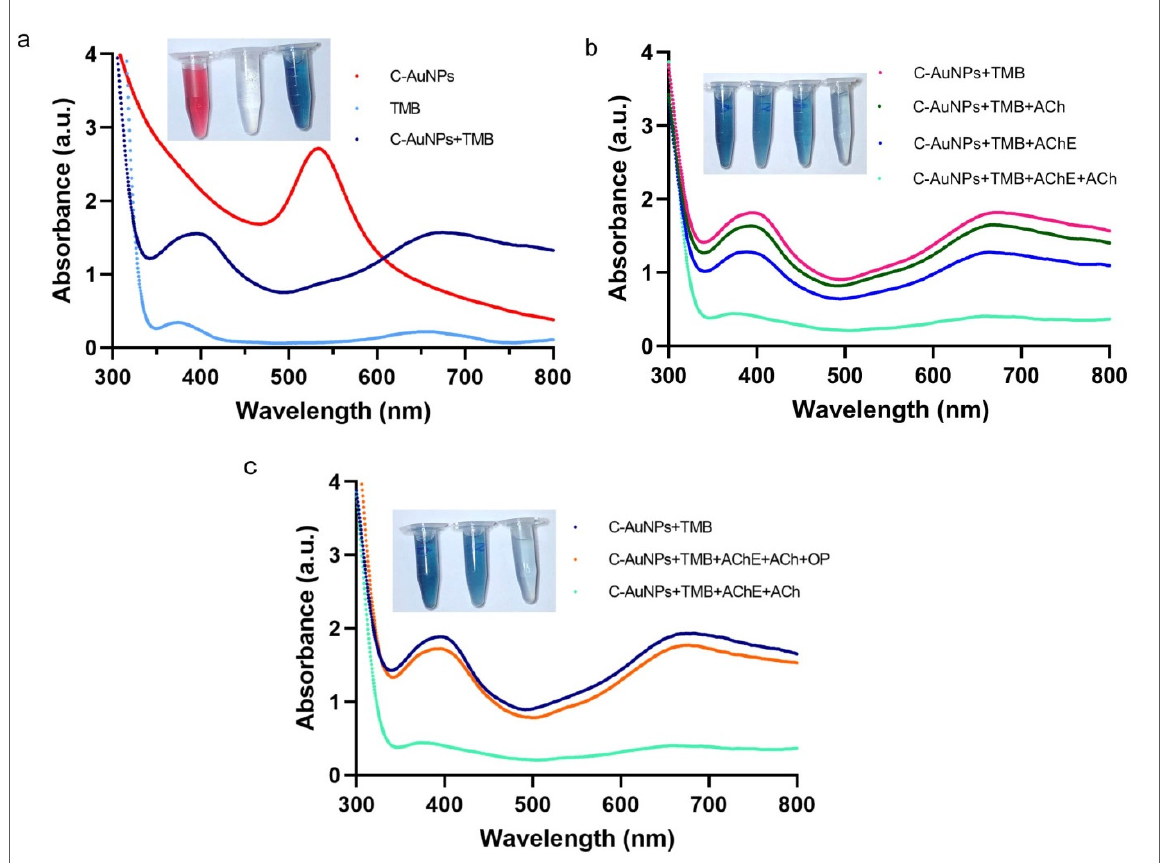
Figure 4. Nanozymic nature of C-AuNPs, affected by choline and PE ( a ) The UV-Vis absorption spectra of C-AuNPs, TMB, and C-AuNPs + TMB confirm the formation of oxTMB. ( b ) UV-Vis absorption spectra confirm that the appearance of choline due to AChE and ACh ultimately causes the aggregation of C-AuNPs. ( c ) The difference in UV-vis spectra in the presence and absence of PE confirms choline production, which leads to the reduction in the catalytic activity of C-AuNPs.